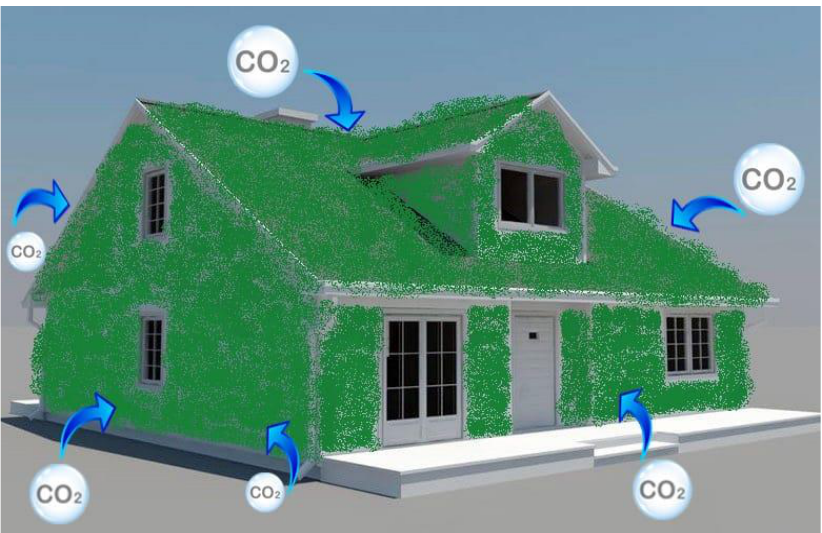
Figure 2. CO 2 absorption concept by virgin ivy plant.